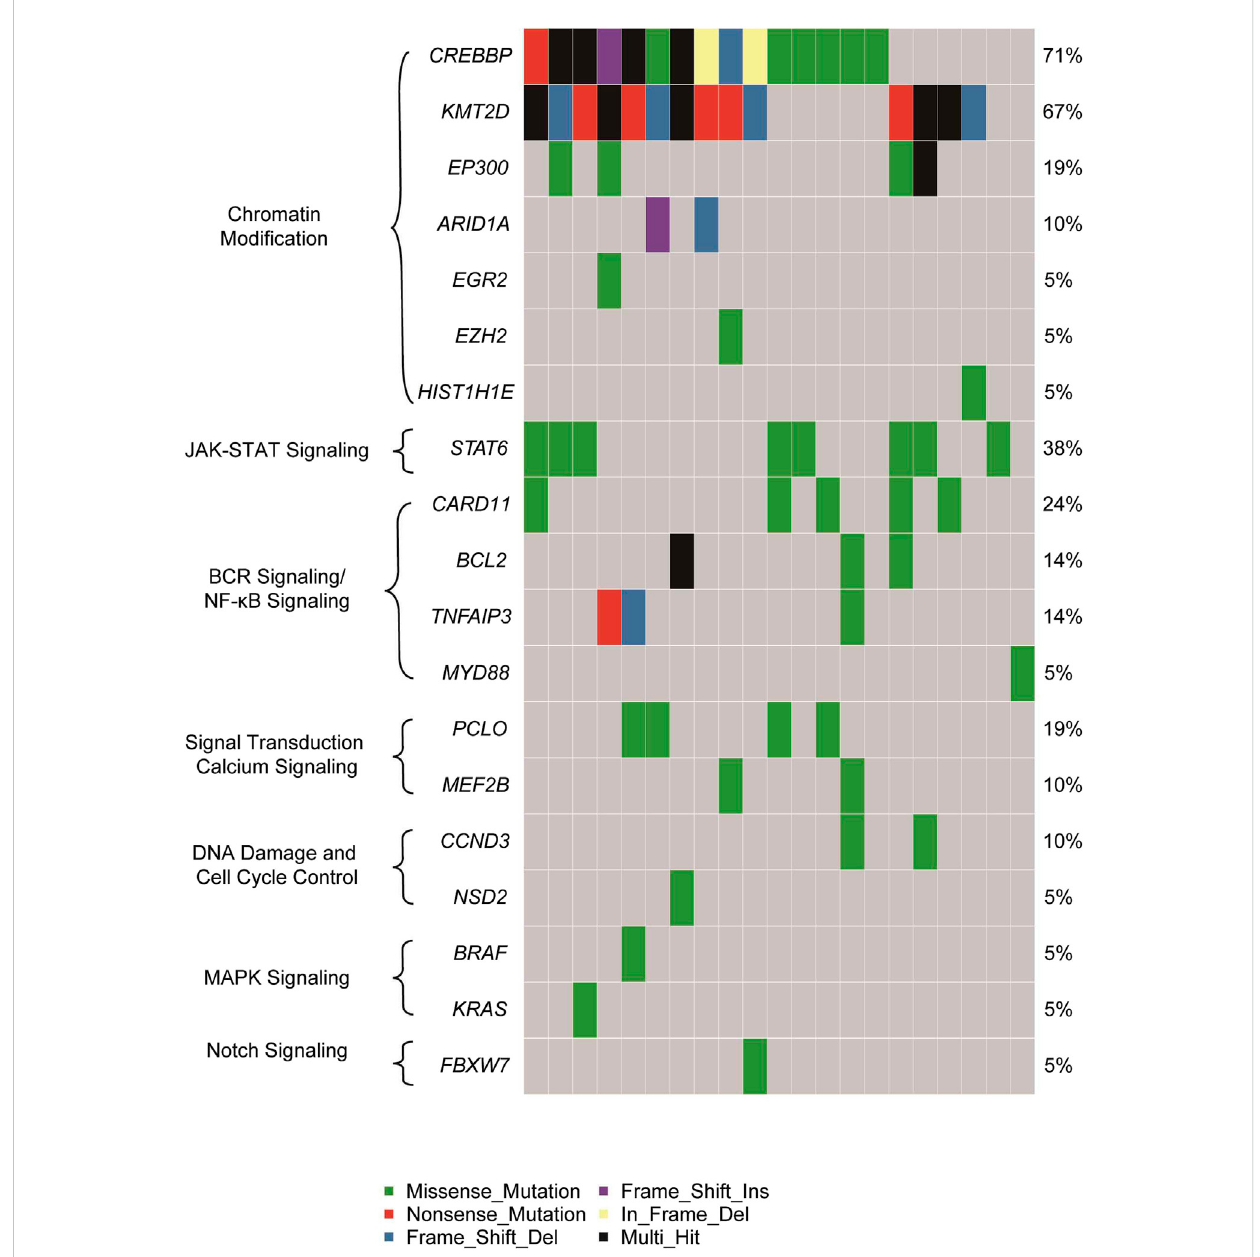
FIGURE 1 Mutation landscape of the ctDNA samples in newly diagnosed FL patients. The X -axis is the sample of individual patients. The upper histogram represents the number of mutated genes per sample. The Y -axis on the left shows the mutated genes, and the percentages on the right chart represent the mutation frequency of mutated